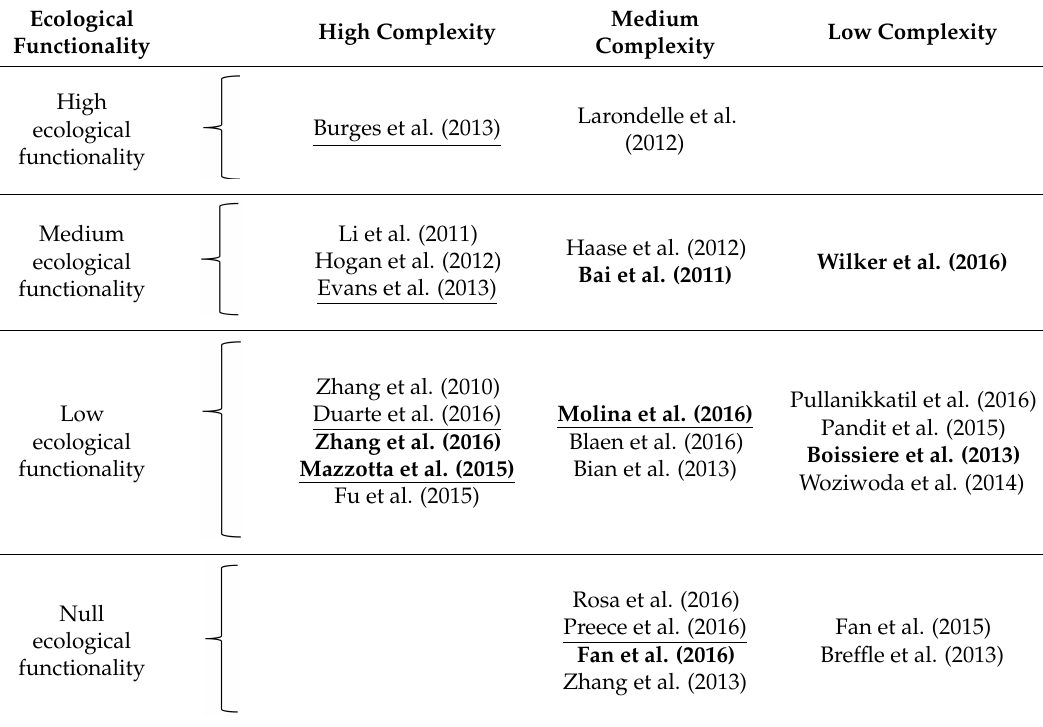
Table 2. ES studies of different complexity (number of parameters) and ecological functionality levels. Models integrating human and ecosystem features are in bold . Uncertainty-explicit models are